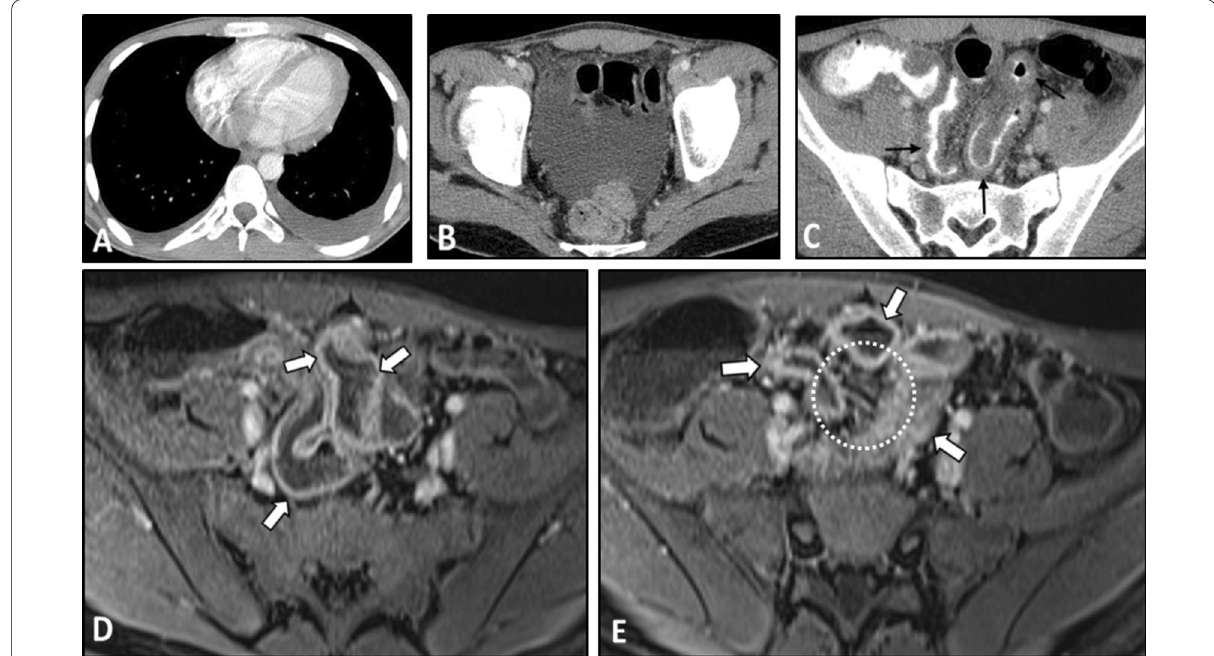
Fig. 9 Intestinal vasculitis in a 28-year-old male with leukocytoclastic vasculitis presenting with abdominal pain, chest discomfort, and erythematous rashes with palpable purpura on the lower extremities. An abdominopelvic CT scan with IV and oral contrast was obtained. Axial images ( A , B ) show mild bilateral pleural effusion and pelvic free fluid. Also, axial CT ( C ) demonstrates mild concentric mural thickening of the distal ileal loop (thin black arrows). The patient underwent a biopsy of skin lesions. The histopathologic study revealed leukocytoclastic vasculitis. Corticosteroid therapy started. Then, MRE was done after five days. Axial post-contrast T1-W images ( D , E ) display mild mural thickening and hyperenhancement (thick white arrows) in the distal ileal segments. Mild engorgement of adjacent mesenteric vessels (white dotted oval) is also evident, and there is no ascites. Imaging findings and clinical data were indicative of an excellent response to